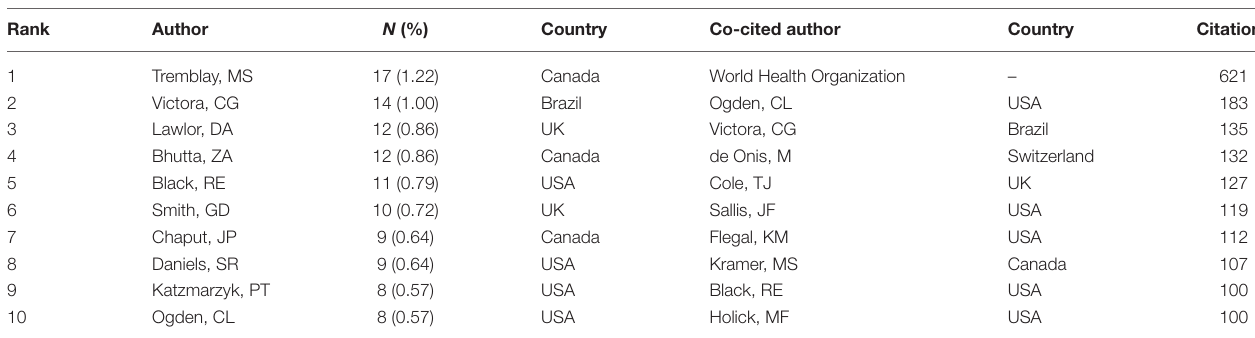
FIGURE 1 | Publication years for HCPs on child nutrition. TABLE 1 | The top 10 authors and co-cited authors [ n